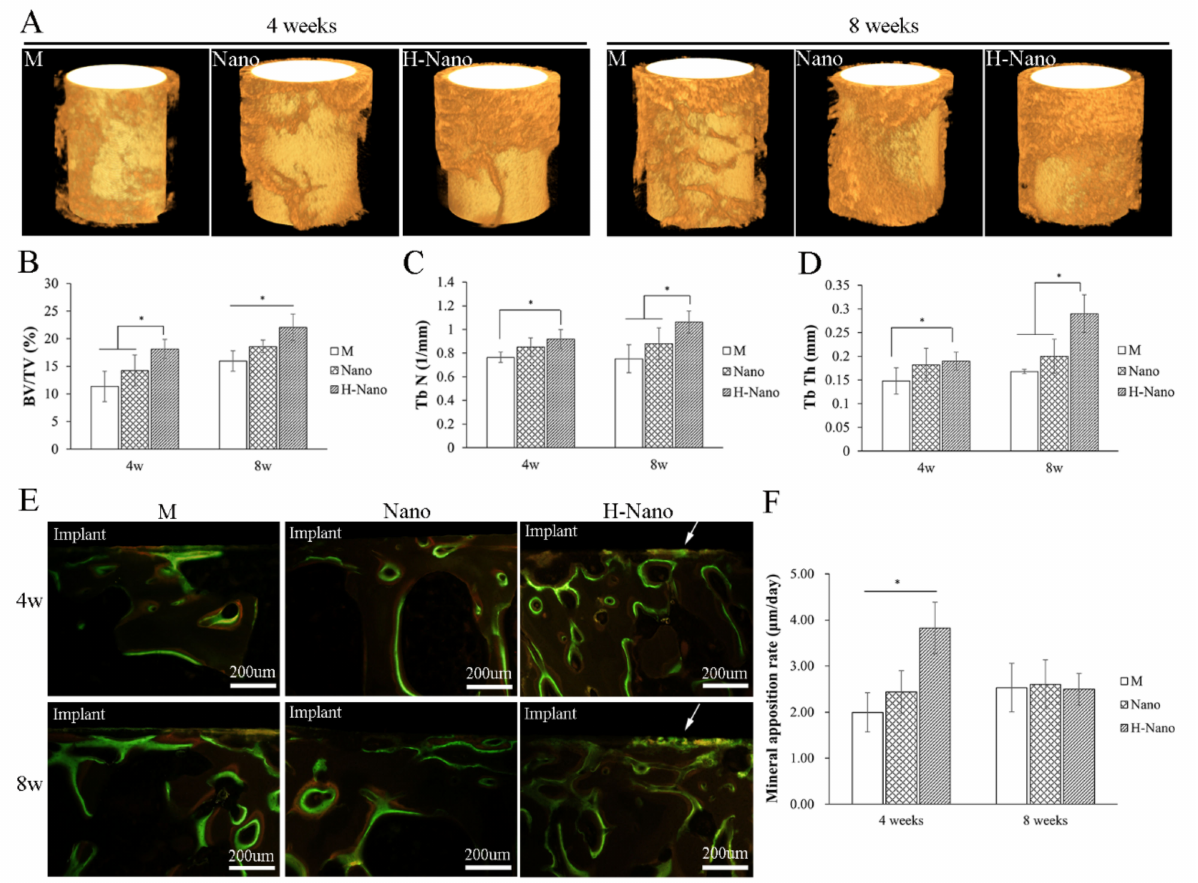
Figure 4. ( A ) Rendered 3D microcomputed tomography images of bone tissue around the M, Nano, and H-Nano implants after 4 and 8 weeks of healing. ( B ) Bone volume/total volume fraction (BV/TV, %), ( C ) trabecular bone number (Tb N), and ( D ) trabecular bone thickness (Tb Th) of three groups obtained from quantitative analysis of the Micro-CT data. ( E ) Double-labeled fluorescent images of the M, Nano, and H-Nano group at 4 and 8 weeks. The fluorescent yellow and green strips represent new bone apposition areas labeled by tetracycline and calcein, respectively. White arrows: contact osteogenesis occurred on the implant surface. ( F ) Quantification of the bone mineral apposition rate in the fluorescence labeled samples. * p <